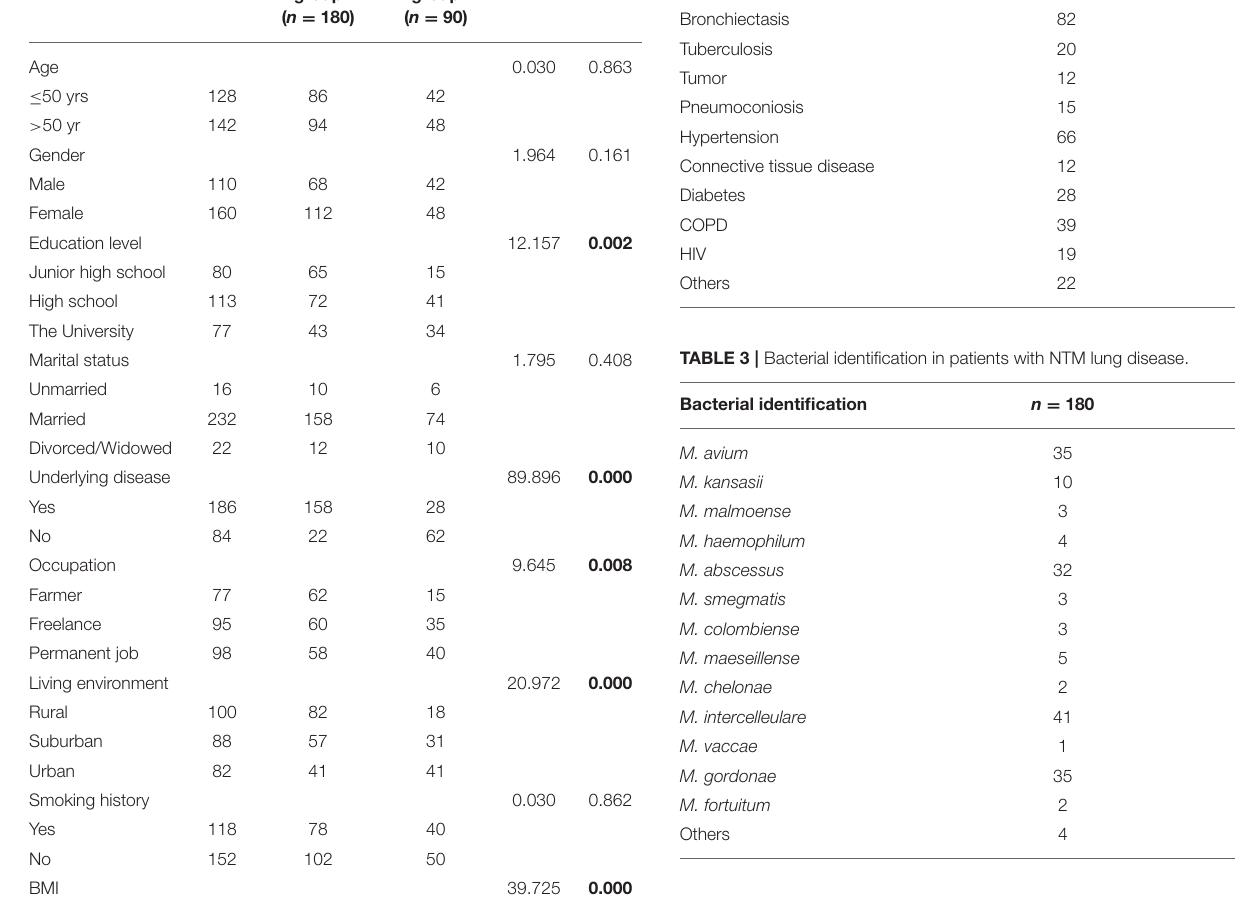
TABLE 1 | Comparison of the sociodemographic characteristics of the two groups of participants. Characteristics